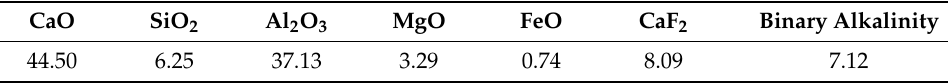
Table 2. The average orthonormal chemical components of slag (wt